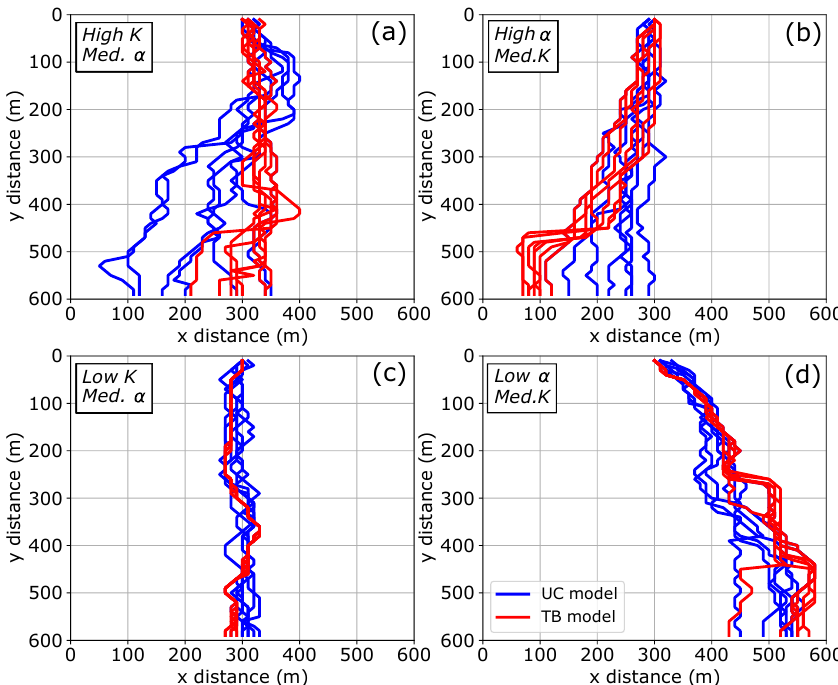
Figure 3. Channel positions over 200kyr with different values for bedrock erodibility and α in the undercutting-slump model (UC model, blue lines) and total block erosion model (TB model, red lines). (a) High bedrock erodibility ( K = 2 . 5 × 10 − 4 ), medium α value ( α = 0 . 8). (b) High α value, indicating low sediment transport ( α = 2 . 0), medium bedrock erodibility ( K = 10 − 4 ). (c) Low bedrock erodibility ( K = 5 × 10 − 5 ), medium α value ( α = 0 . 8). (d) Low α , indicating high sediment transport ( α = 0 . 2), medium bedrock erodibility ( K = 10 − 4